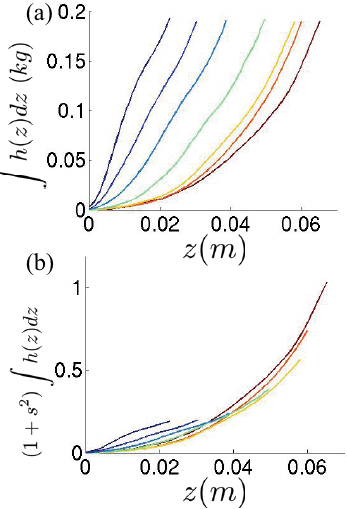
(cid:2) Figure 4. (a) h ( z ) dz versus z for all intruders, ranging from s = 0 to s = 2.1. Colors correspond with s values of fig. 2. Higher s lowers the curve to smaller inertial drag values. (b) The data collapse to one curve when scaled as a function of s